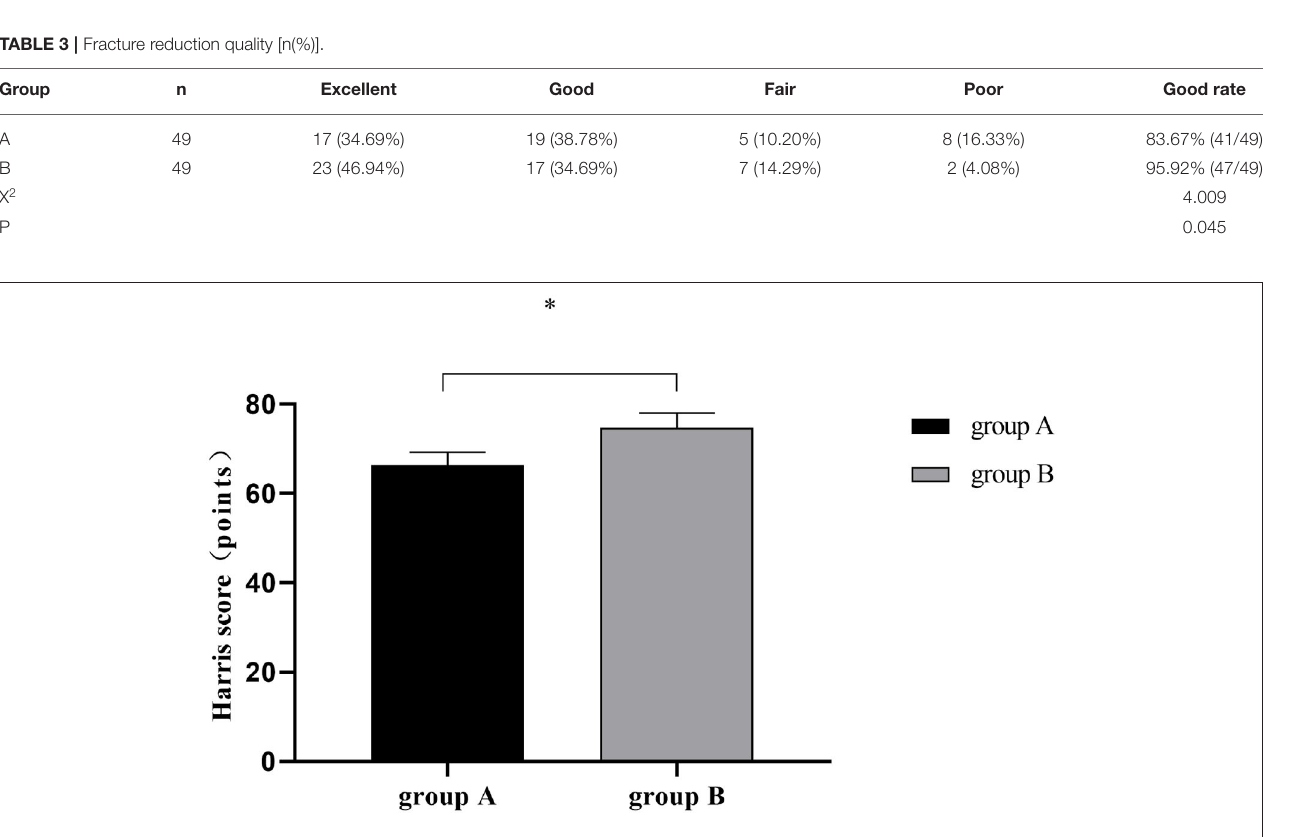
FIGURE 2 | Postoperative Harris scores [Mean ± SD]. The horizontal axis denoted groups A and B, and the vertical axis denoted the Harris score (points); After surgery, the Harris scores of groups A and B were respectively (66.37 ± 2.83) and (74.78 ± 3.28); and *indicated a significant between-group difference in postoperative Harris scores (t = 13.589, P <